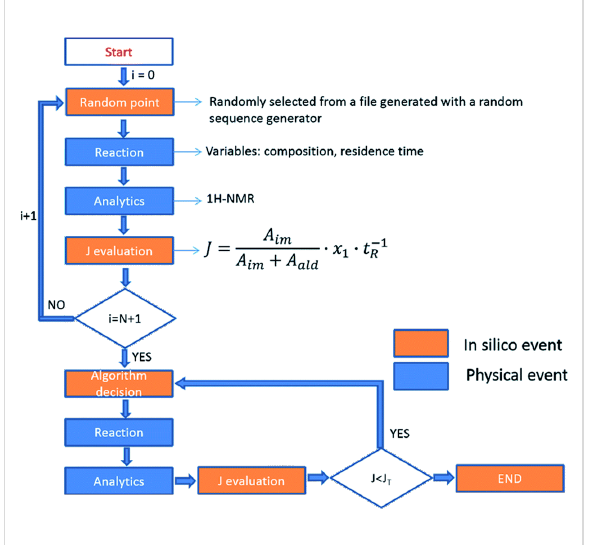
Figure 15: Flow diagram showing the self-optimizing reactor system. Reproduced with permission from reference [50]. Copyright 2015 The Royal Society of